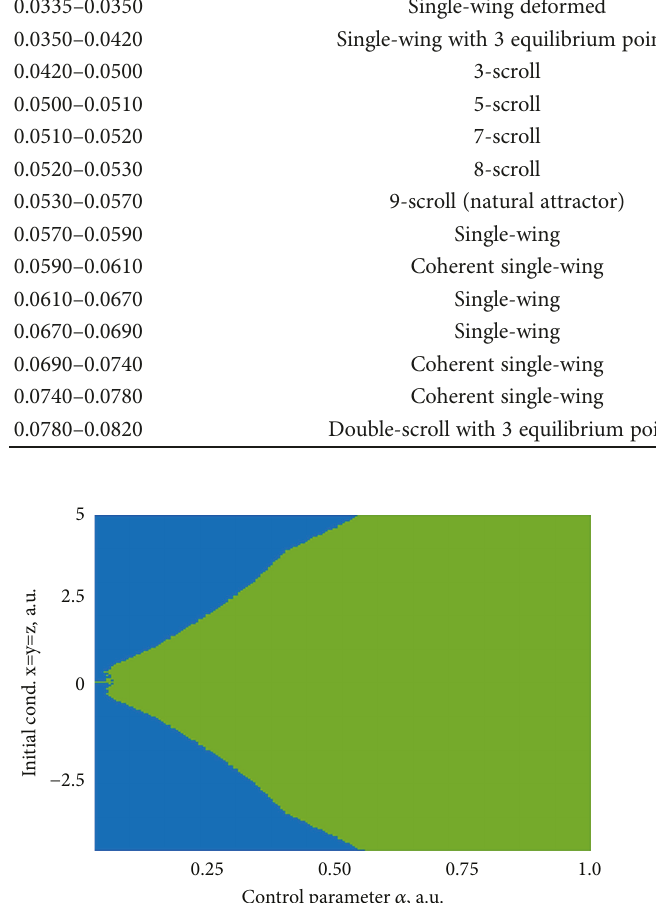
= y = z ci ci for the natural ci